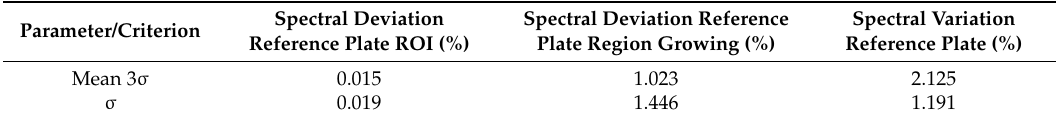
Table 4. Objective evaluation of the spectral